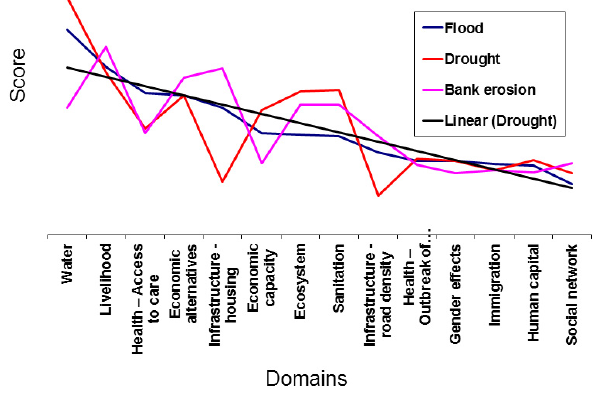
Figure 5. Domain weighting with